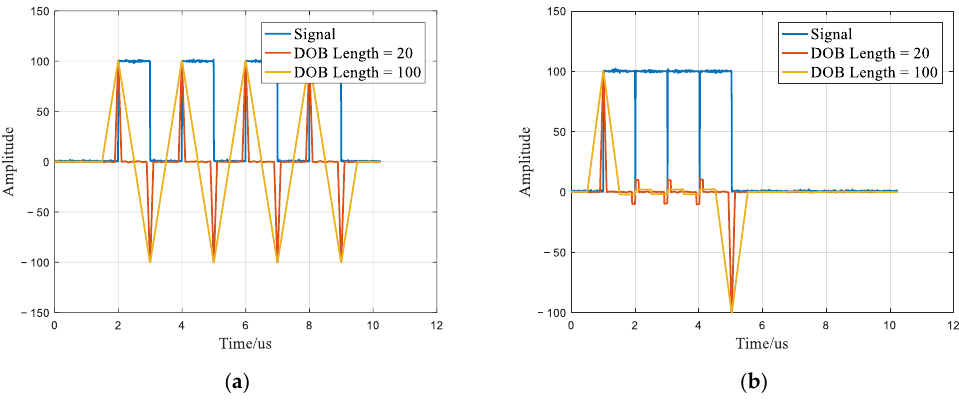
Figure 7. DOB edge detection curves of jamming with ( a ) Jamming pulses forward discontinuously; ( b ) Jamming pulses forward continuously.